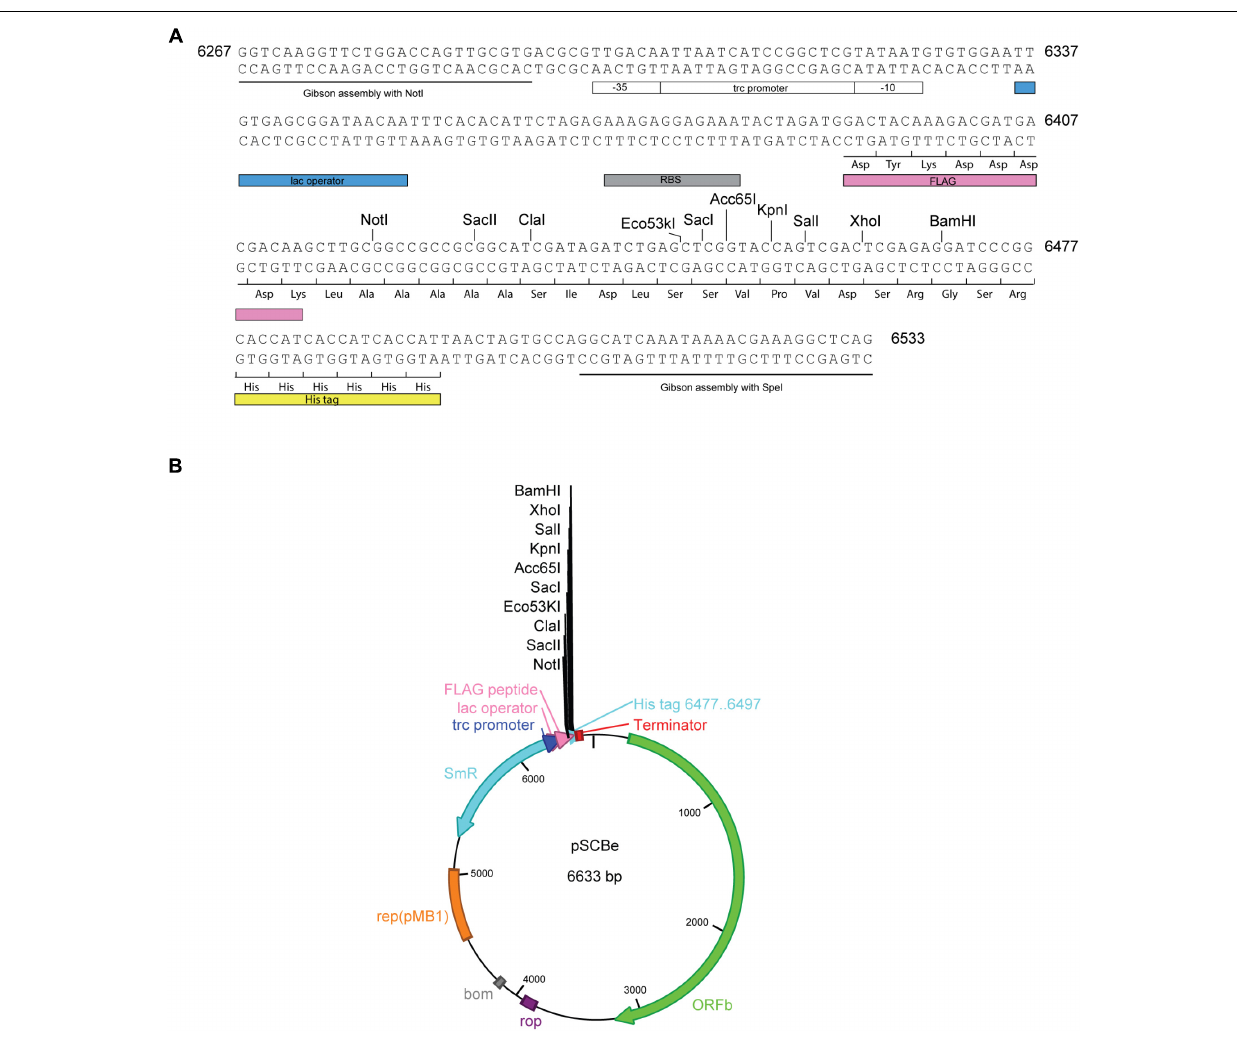
Frontiers in Microbiology |